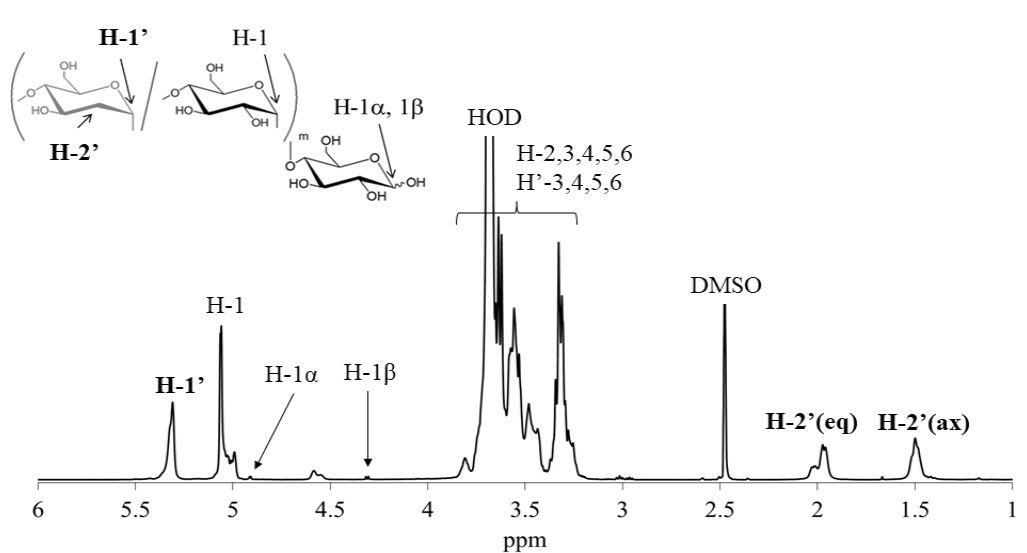
Figure 2. 1 H NMR spectrum of partially 2-deoxygenated amylose (entry 4) in DMSO- d 6 /D 2 O.